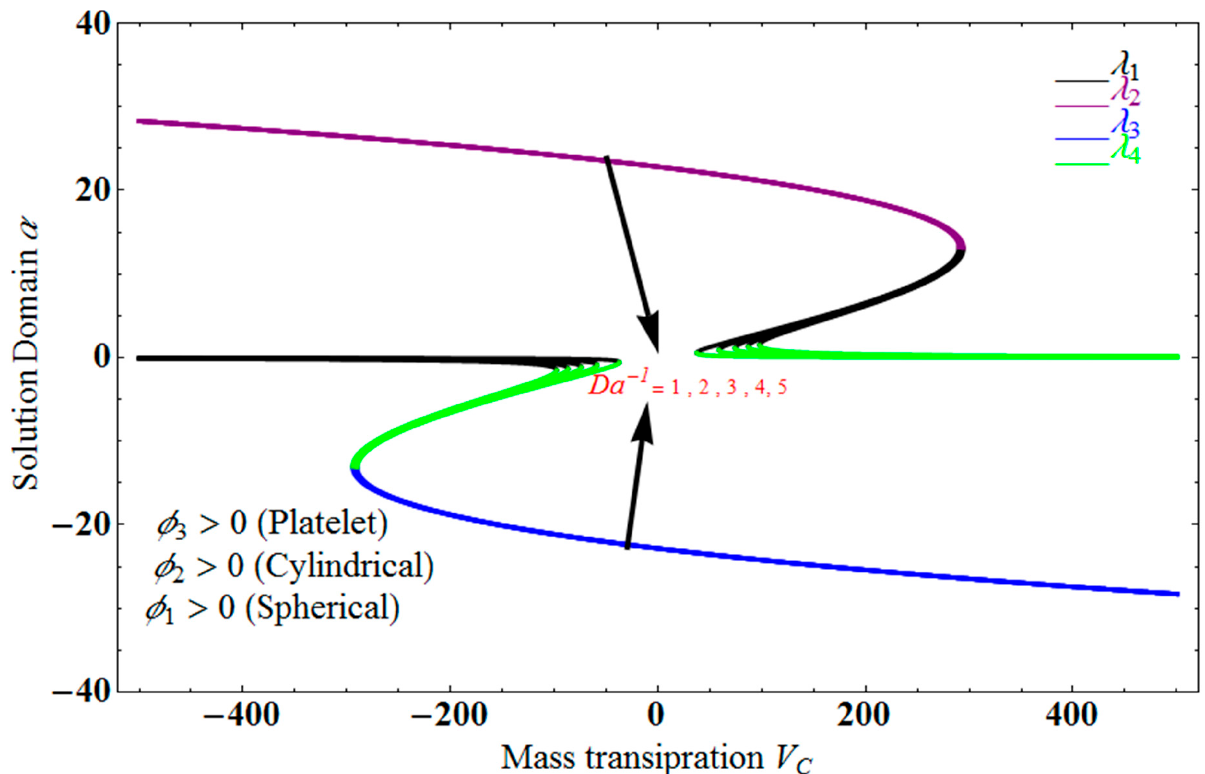
α verses mass transpiration